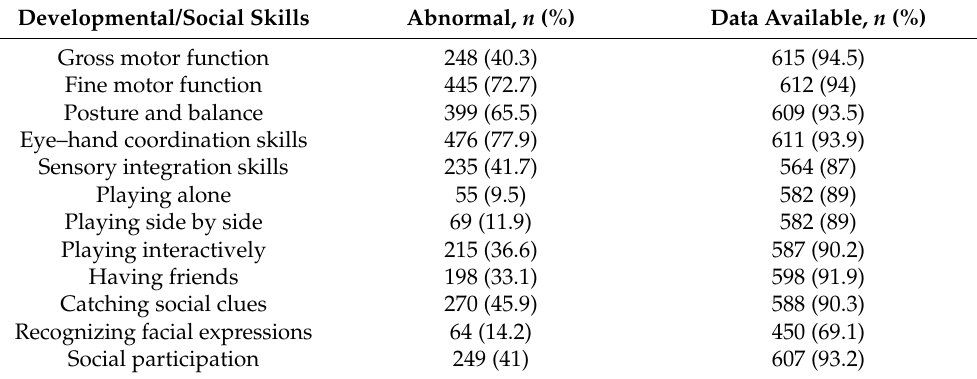
Table 2. Abnormal findings in different neurological developmental domains for those individuals with data